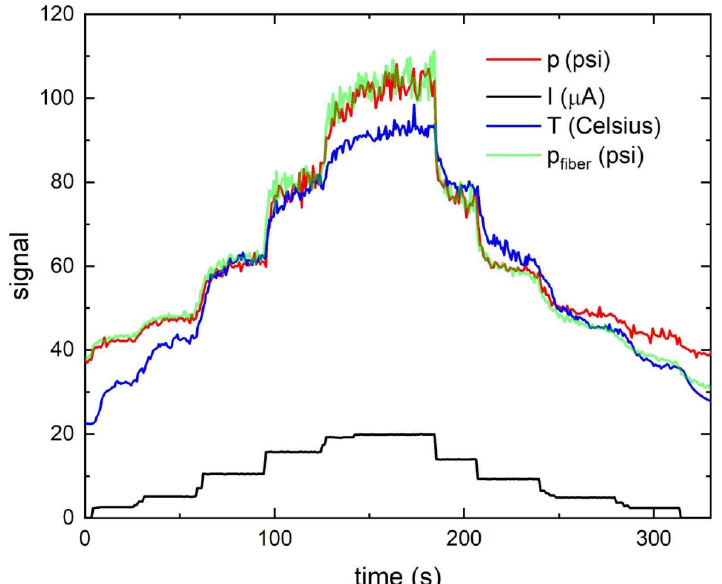
Figure 7. Results from the second isotope production experiment illustrating the results of an irradiation of naturally abundant water. The black curve shows the set point proton beam current. The red curve represents the readings of the reference pressure transducer attached to the target body. The green curve illustrates the readings of the Fibos FBG-based pressure transducer. The blue curve shows the readings of the Fibos FBG-based temperature probe which was inserted 11 mm into the water without touching the opposite wall of the target body. The unit of the individual signals is listed in the legend.